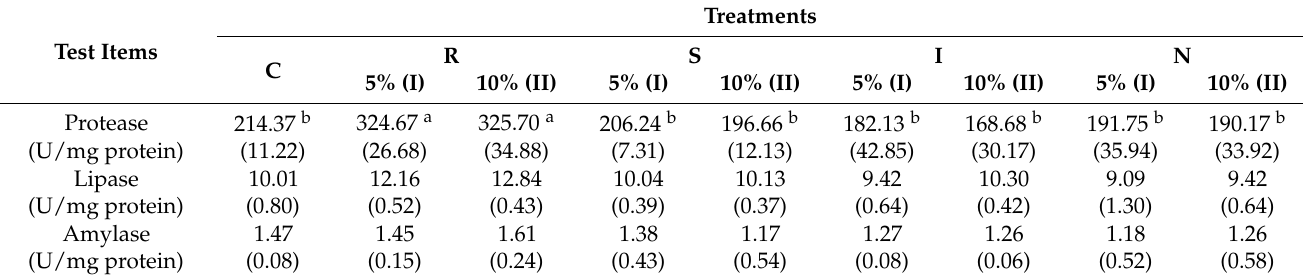
Table 6. Activity of digestive enzymes in G. columna after 8 weeks of feeding with different aquaculture feeds.